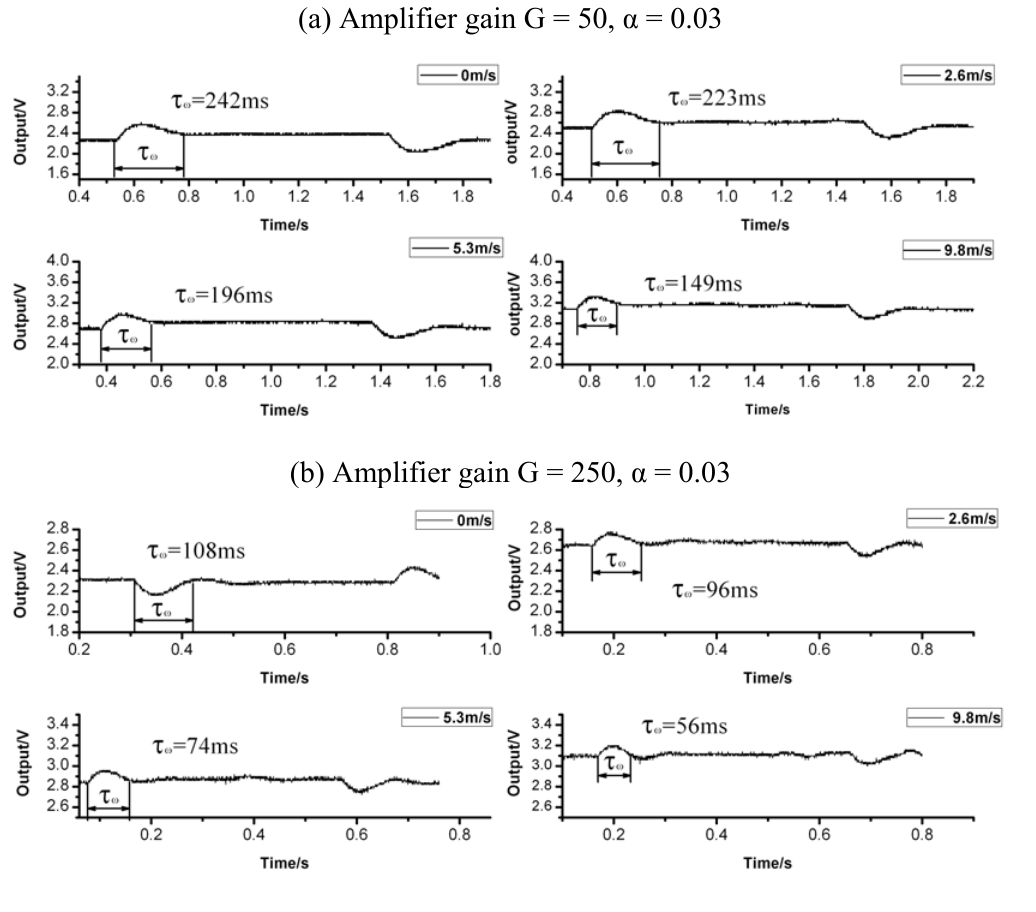
Table 1. Response time under different conditions (corresponds with τ